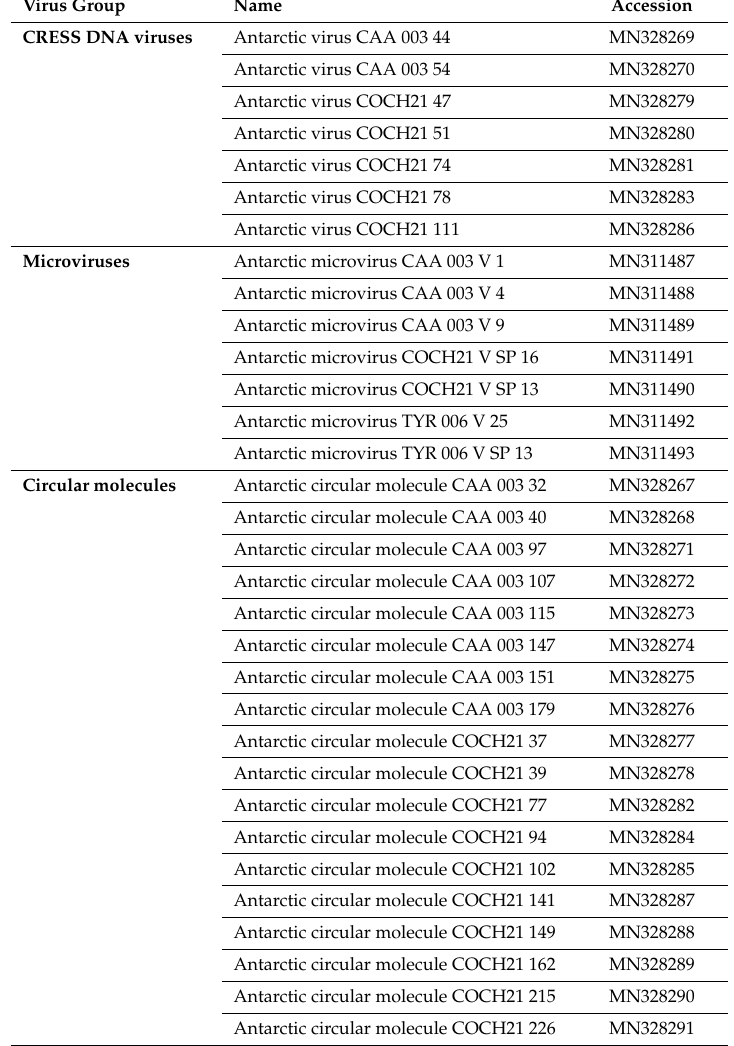
Table 1. Summary of viruses and circular molecules identified in this study and their GenBank accession